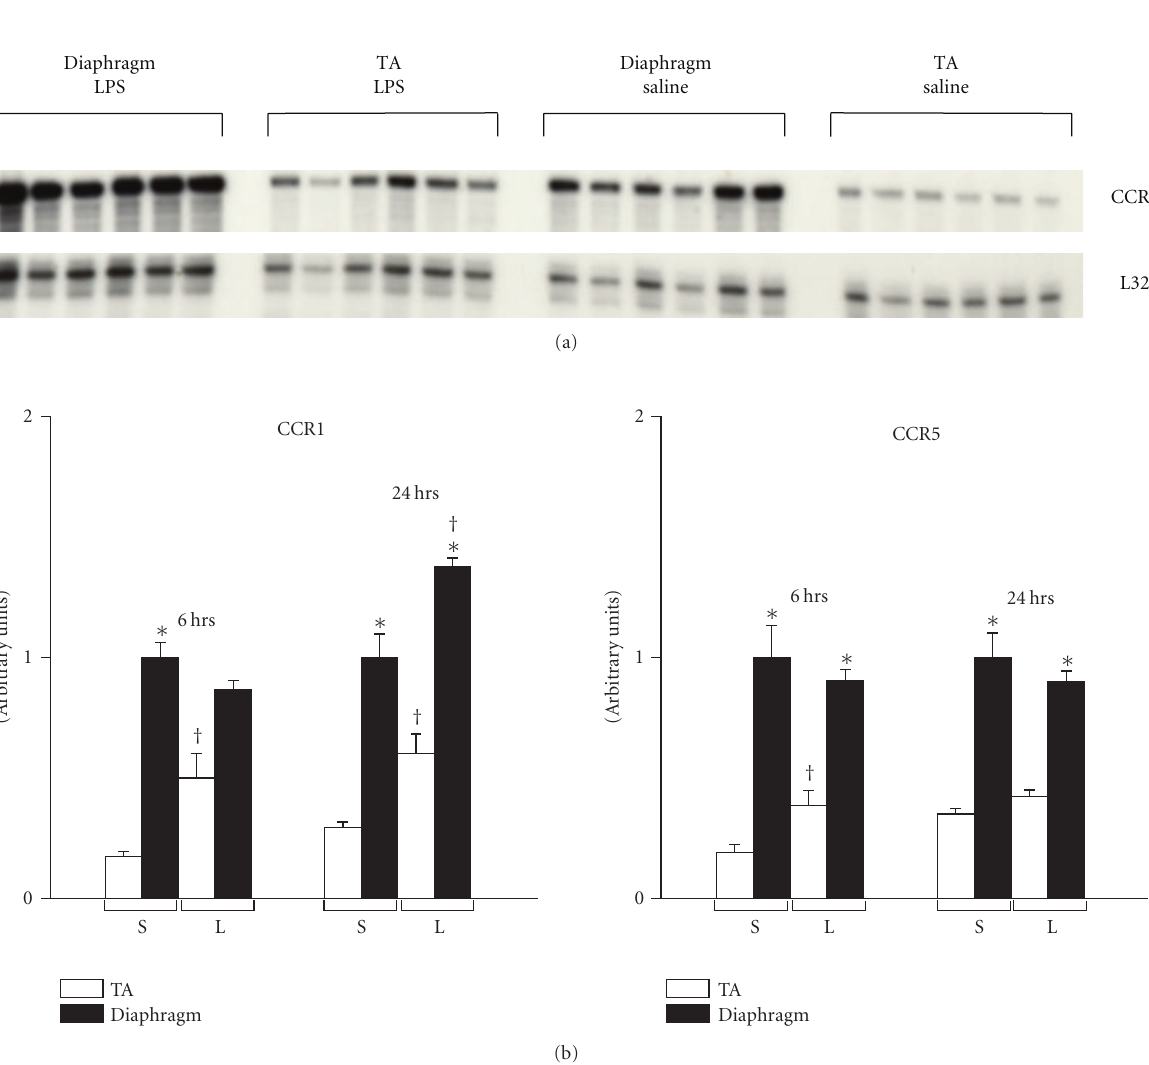
Figure 1: CC-class chemokine receptor gene expression in the diaphragm and limb muscle at baseline and during endotoxemia in vivo. (a) Representative autoradiograph of ribonuclease protection assay data, showing CCR1 gene expression in the mouse diaphragm and tibialis anterior (TA) muscles at 24 hours following injection of either LPS or saline. (b) Quantification of CCR1 and CCR5 mRNA levels at 6 and 24 hours after LPS administration. Note that the samples for each time point were loaded onto separate gels, such that the absolute arbitrary units depicted are valid for quantitative comparisons within but not between time points. All data are group means ± SE, n = 6 mice per group. Data are normalized to the L32 housekeeping gene. ∗ P < . 05 for comparisons between diaphragm and TA within the same condition (LPS or sham control); † P < . 05 for comparisons between LPS- and sham-control- (saline-) treated mice within the same type of muscle (diaphragm or